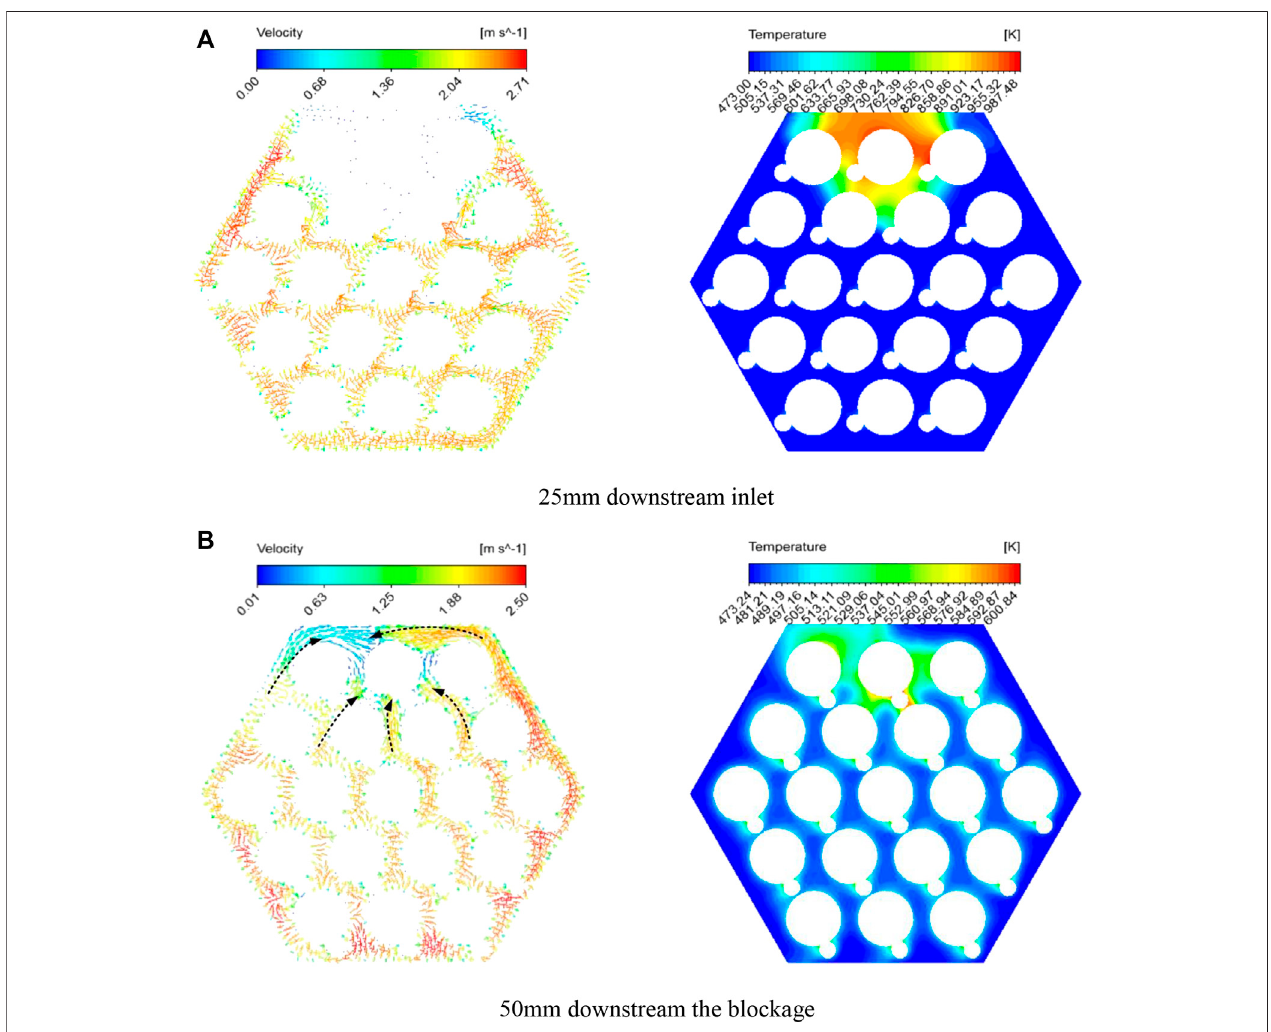
FIGURE 10 | The vector and temperature contours in case 4. (A) 25 mm downstream of inlet. (B) 50 mm downstream the of blockage.